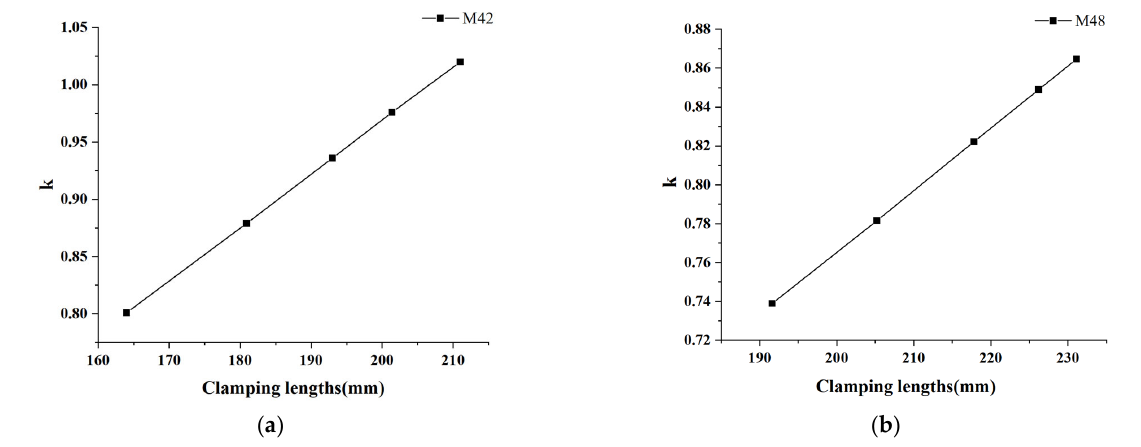
Figure 6. Relationship between 𝛥𝑡 and the axial load under different clamping lengths for ( a ) M42 bolt; ( b ) M48 bolt.